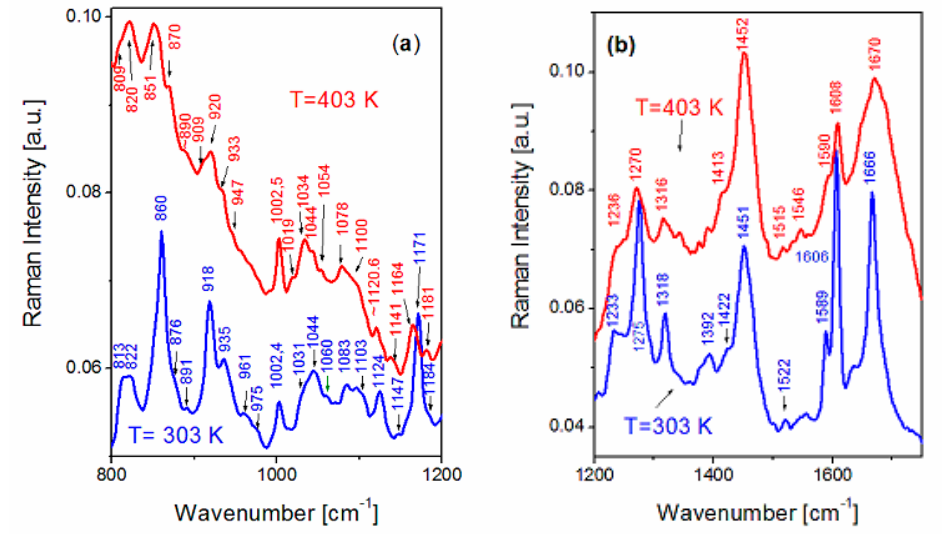
Figure 4. Comparison of Raman spectra of FS collagen measured at 303 K and 403 K in the frequency ranges 800–1200 cm − 1 ( a ) and 1200–1750 cm − 1 ( b ).